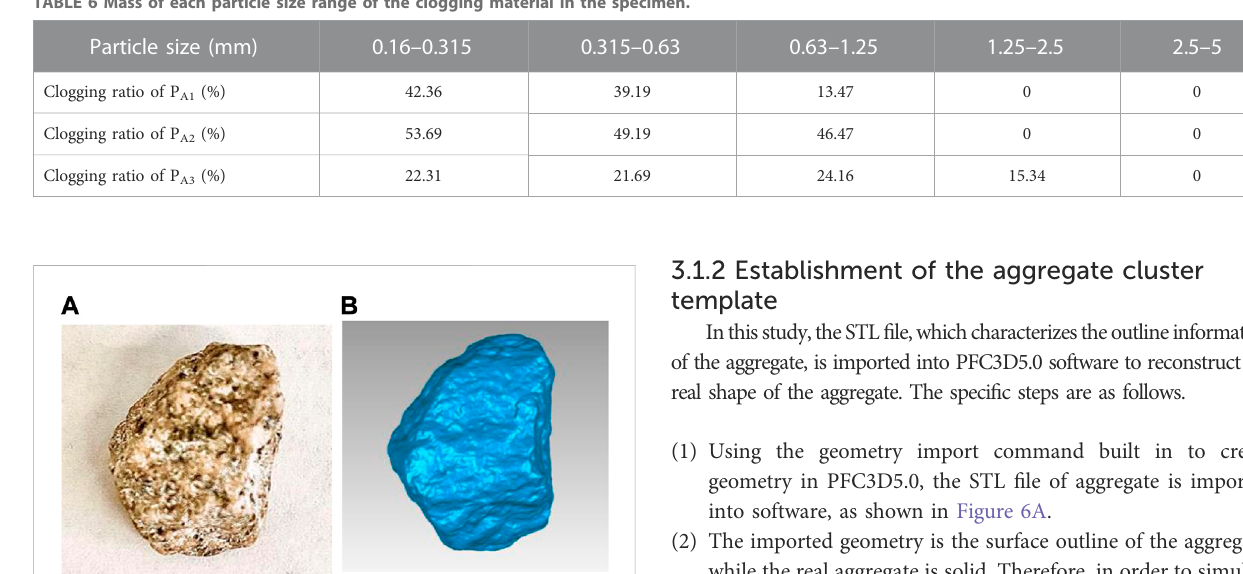
FIGURE 5 True shape of the aggregate and the shape of the aggregate obtainedbyscanning: (A) trueshapeoftheaggregate; (B) shapeofthe aggregate obtained by